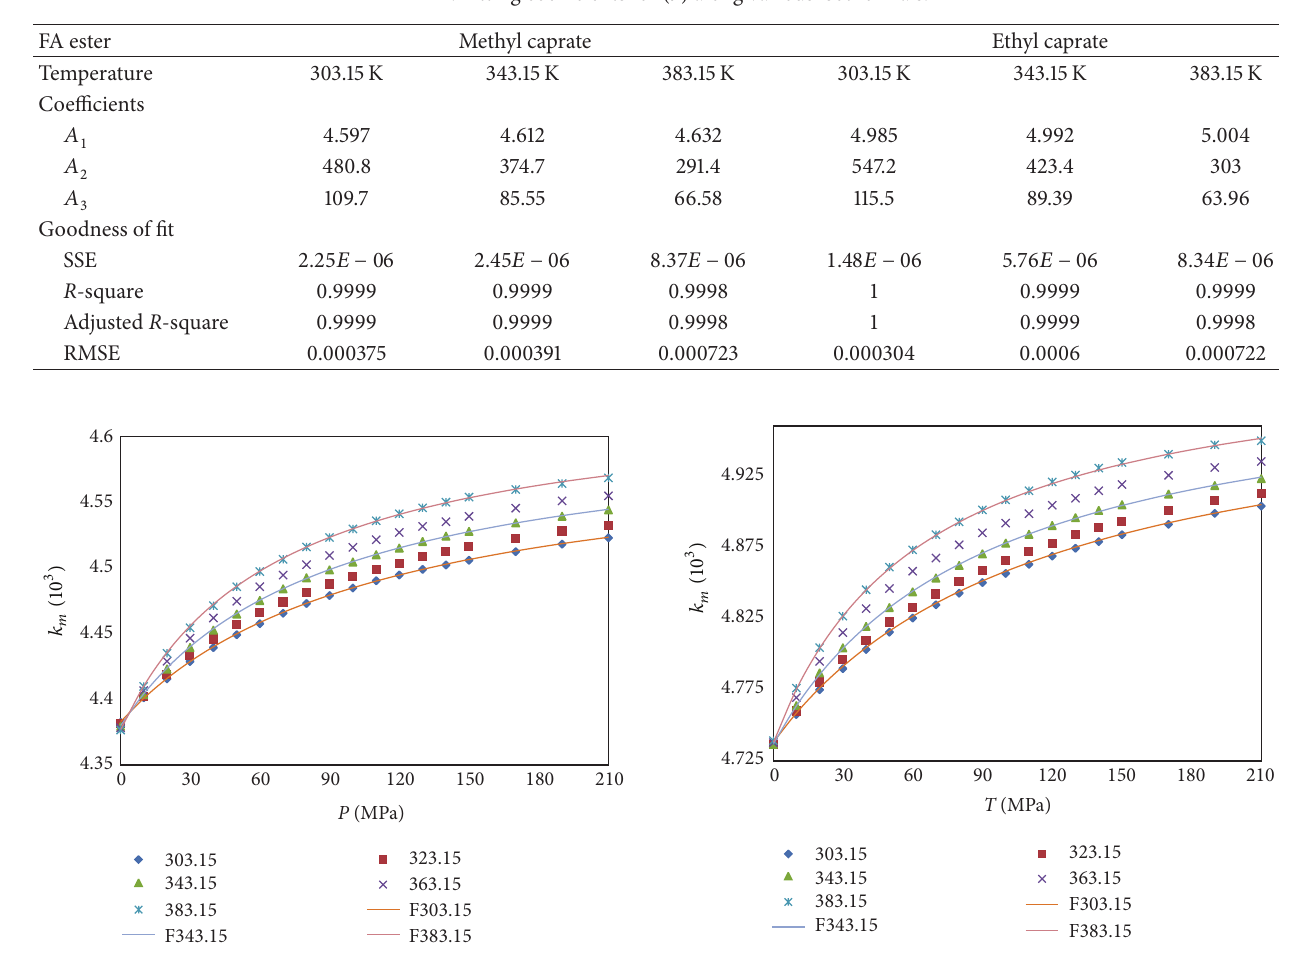
Figure 1: Molecular compressibility of methyl caprate (MeC10:0) as a function of pressure along various isothermal (the lines are fitting results; the dots are calculated values).